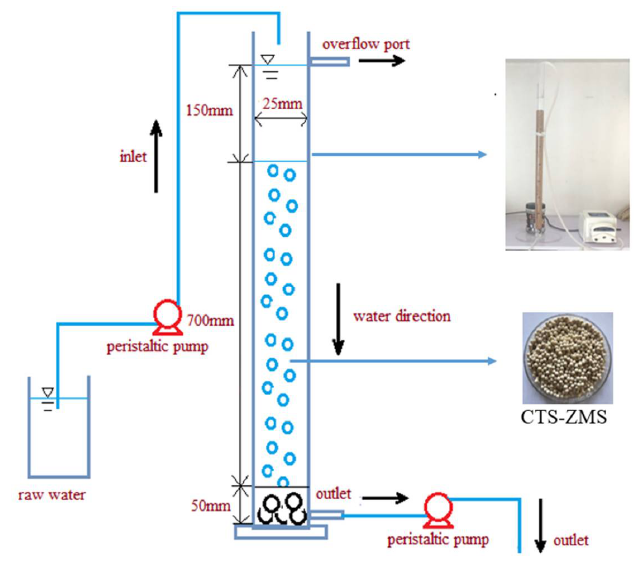
Figure 1. Schematic of chitosan crosslink with zeolite molecular sieve (CTS-ZMS) composite dynamic adsorption equipment.